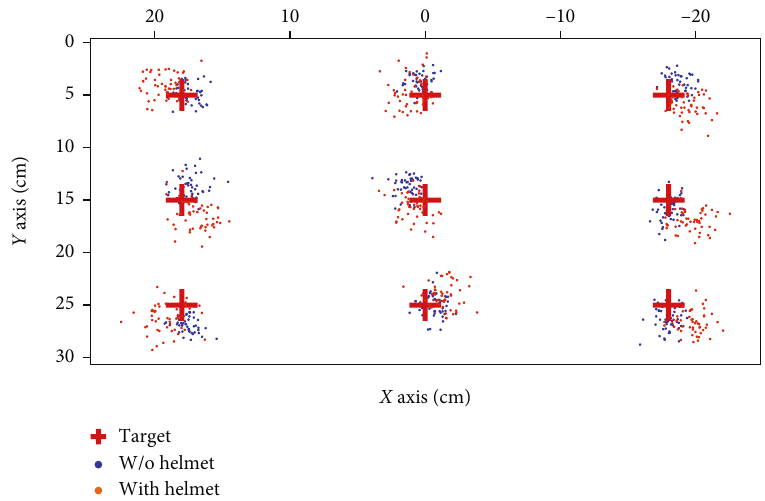
Figure 10: Visualized results of gaze marker landing estimation with subjects at 40cm away from the